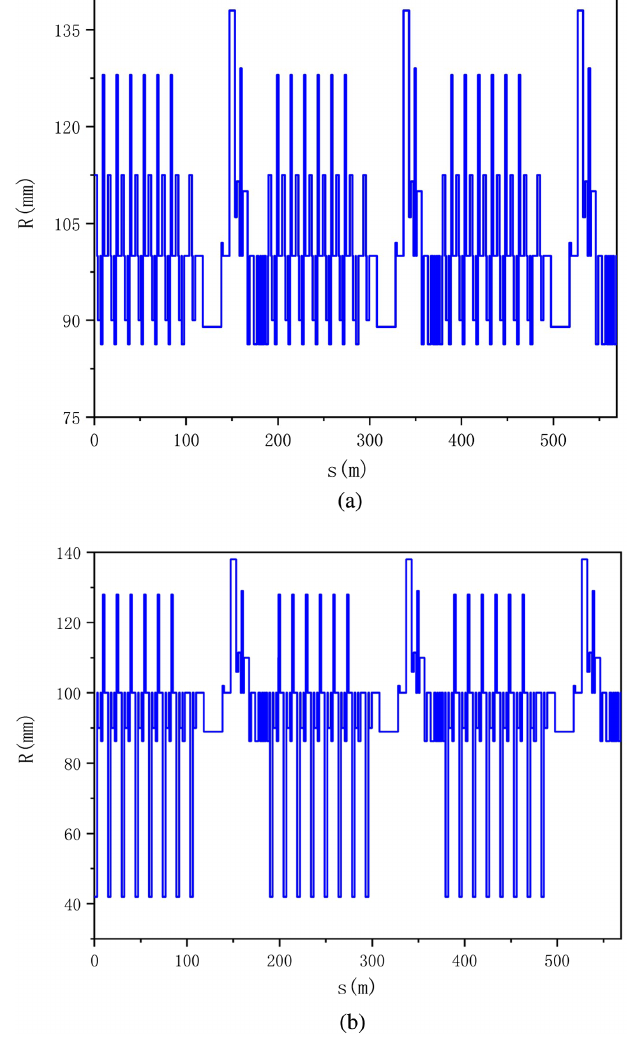
FIG. 7. Variations of radius for beam pipe. (a) Horizontal (b)